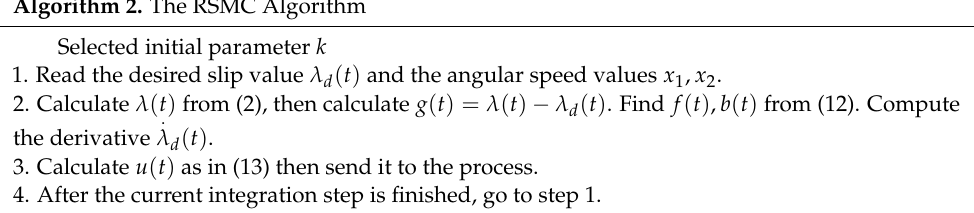
Algorithm 2. The RSMC